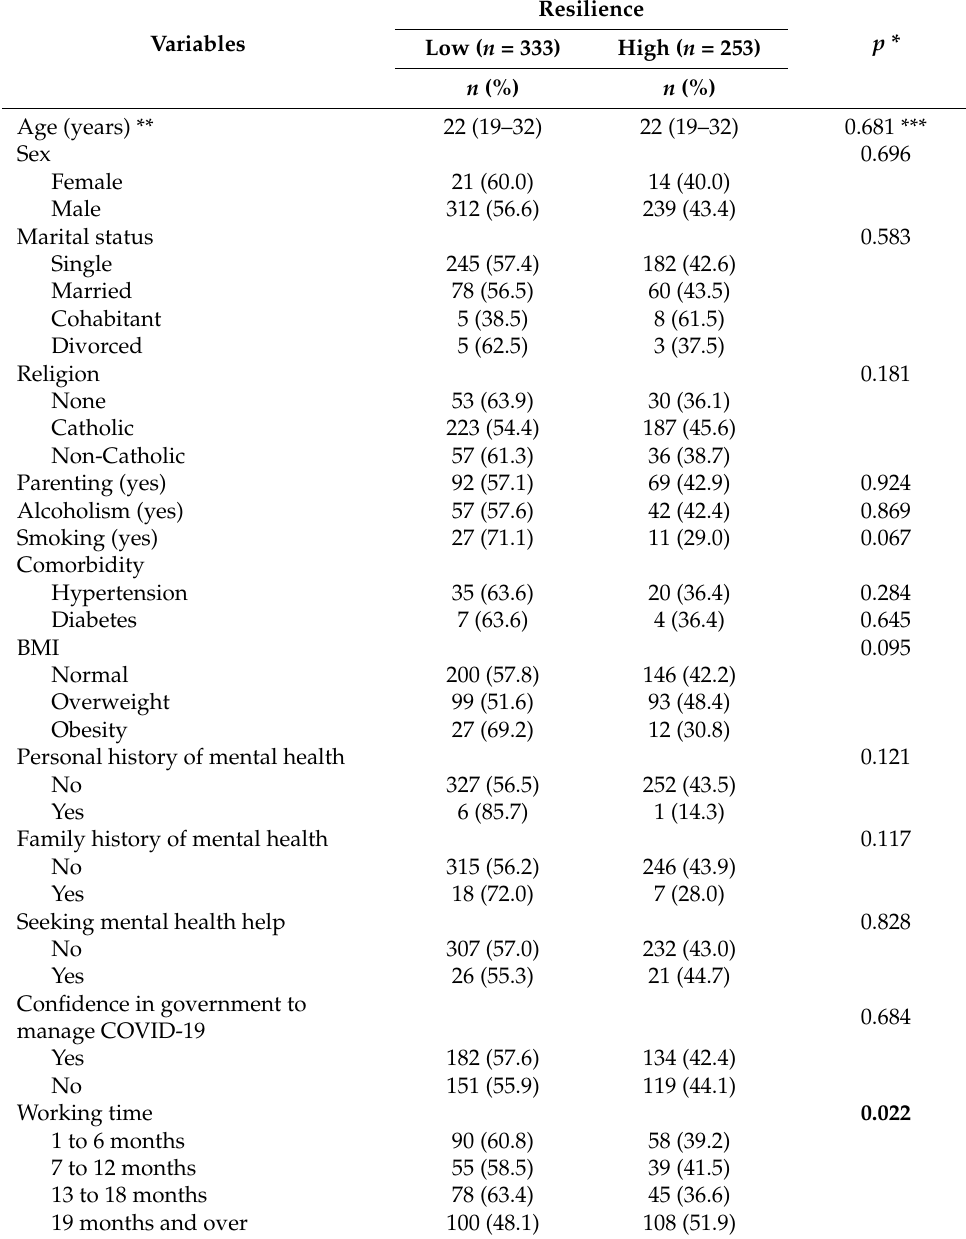
Table 2. Characteristics associated with resilience in bivariate